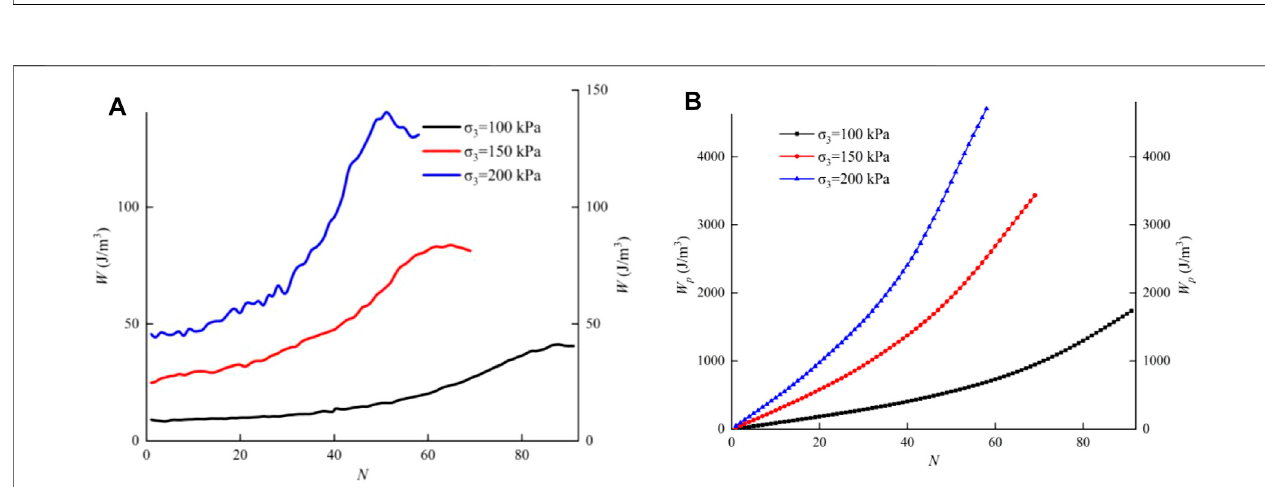
FIGURE 10 | Evolution characteristics of dissipated energy under different con fi ning pressures: (A) dissipated energy per cycle and (B) cumulative dissipated energy.